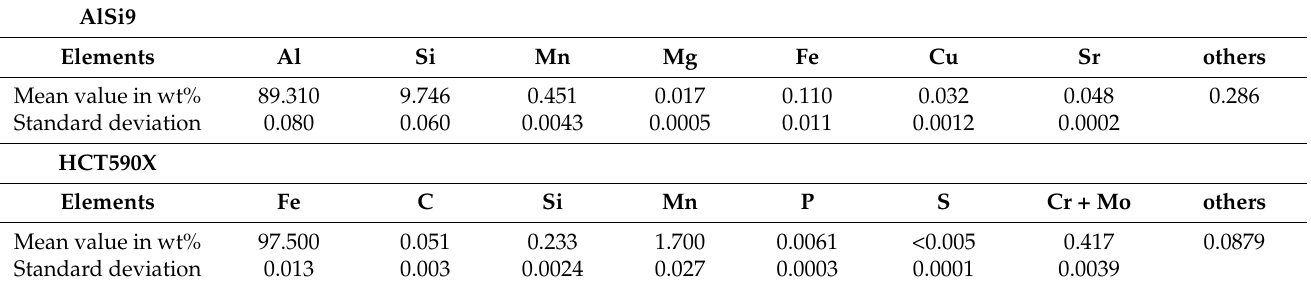
Table 2. Chemical composition of AlSi9 and